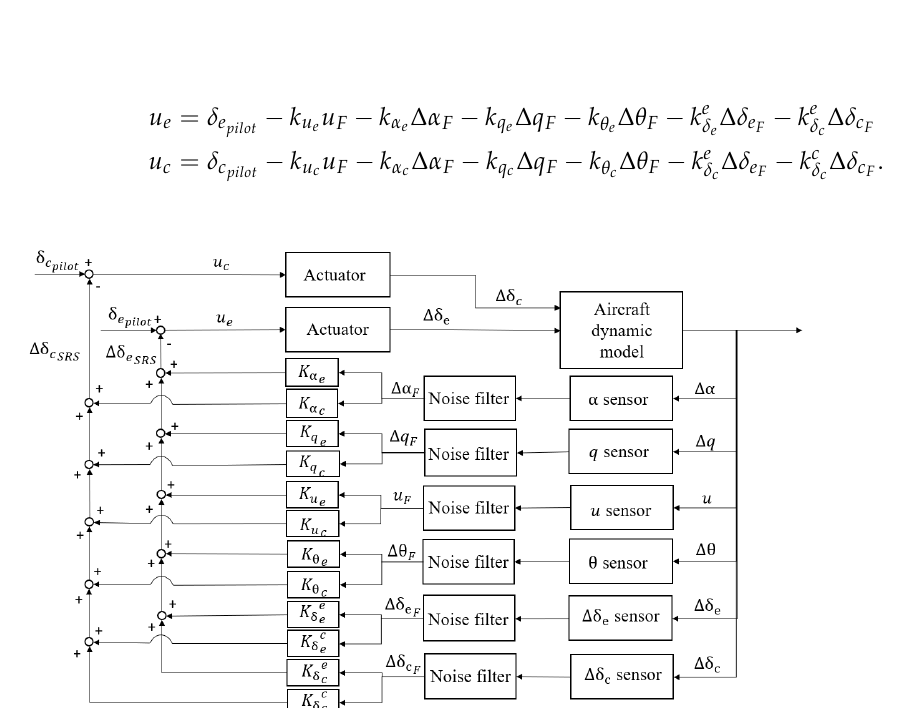
Figure 8. Scheme B for dynamics reassignment of a three-surface aircraft.